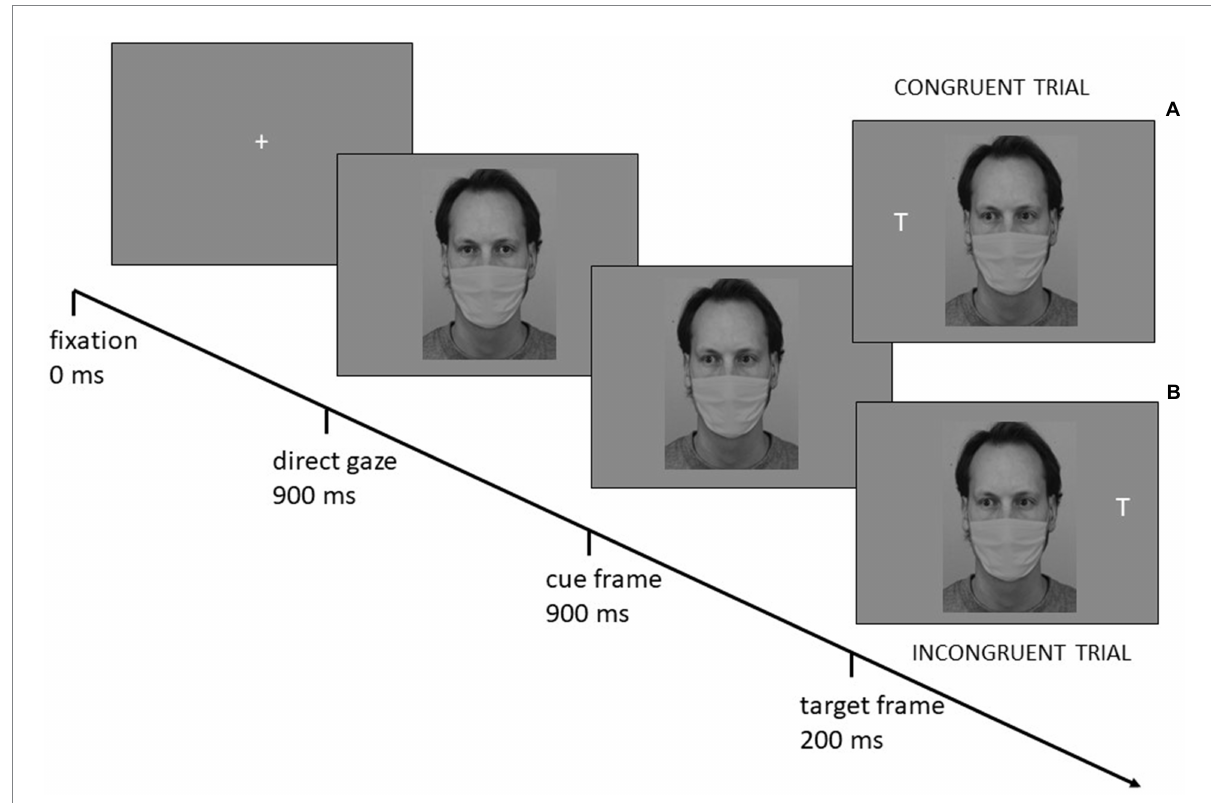
FIGURE 2 Illustration of the gaze-cueing procedure depicting examples of Mask condition stimuli (not drawn to scale) and sequence of events for a congruent trial (top) and an incongruent trial